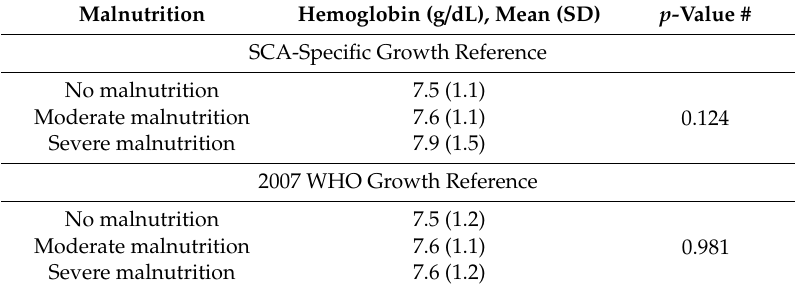
Table 3. Mean hemoglobin of children with sickle cell anemia (SCA) aged 5–12 years old in Nigeria (SPRING cohort; n = 799): WHO compared to the SCA-Specific growth